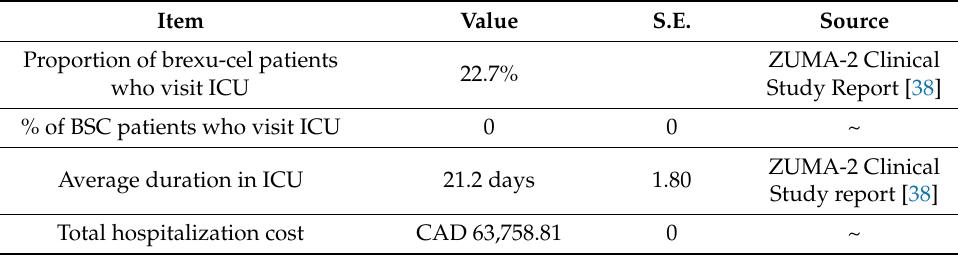
Table A5. Hospitalization of